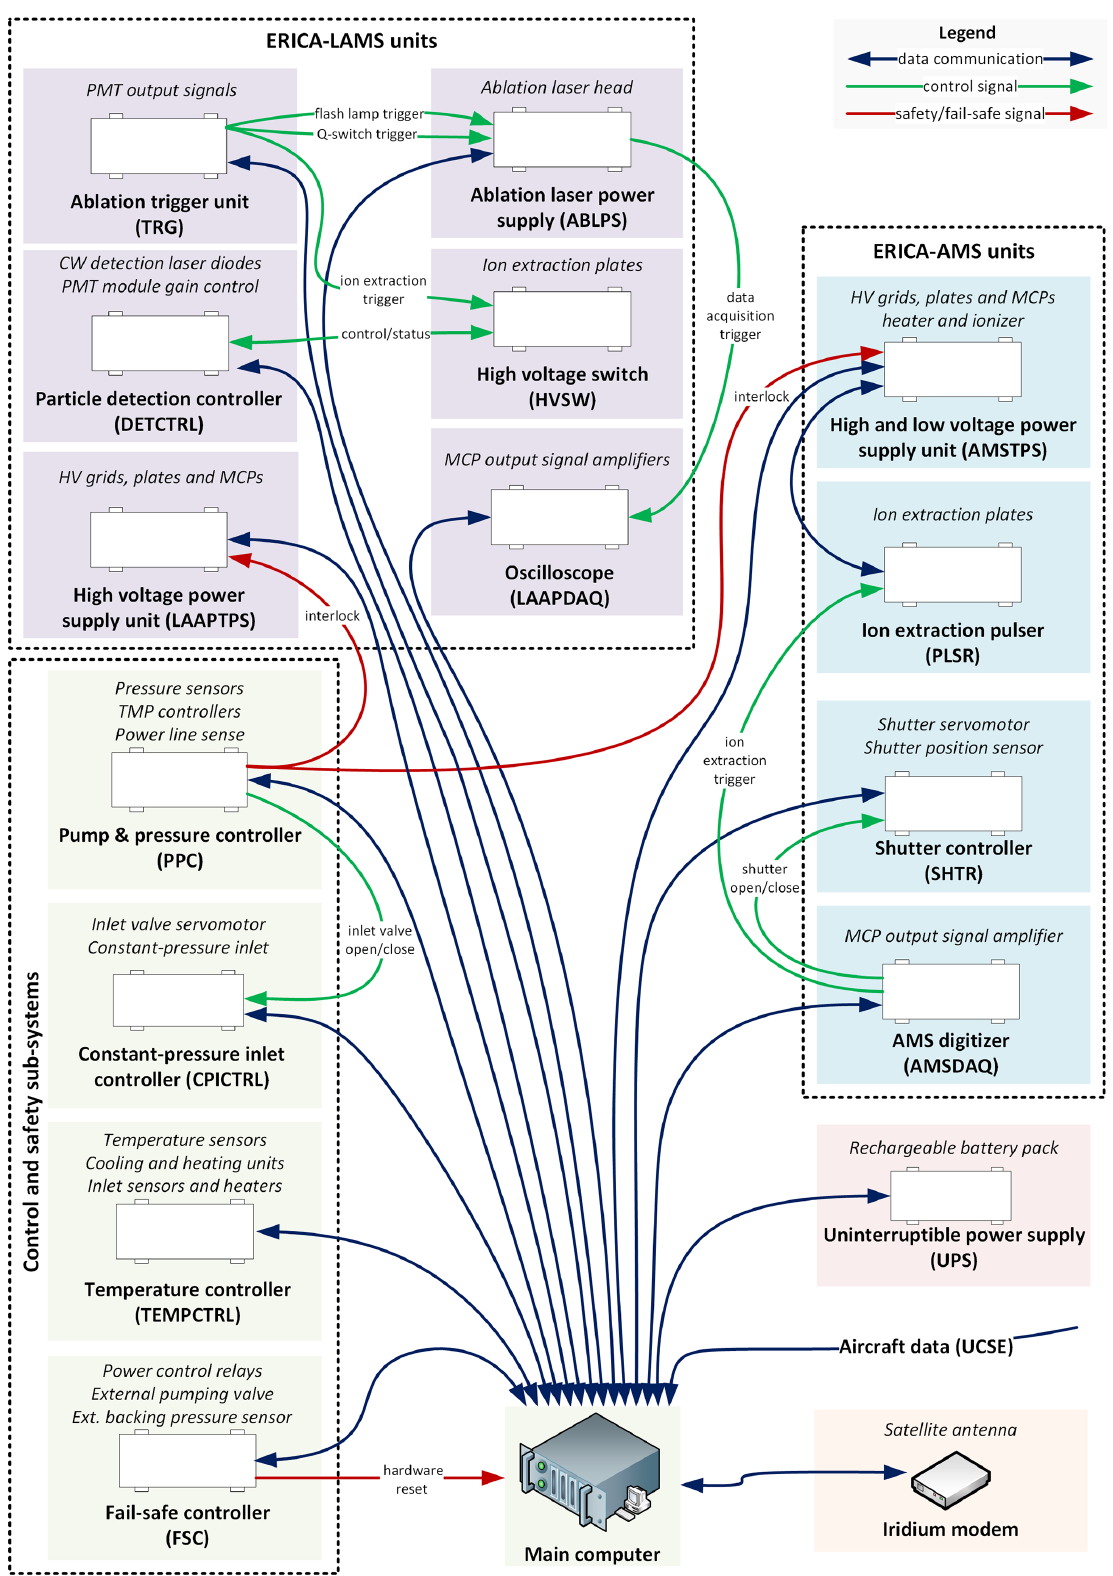
Figure 4. Overview of the major electronic sub-systems of the ERICA. Text in italic names additional units connected to each